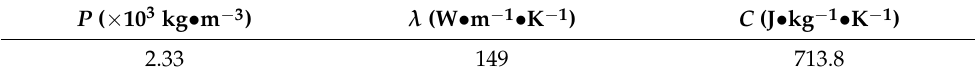
Table 1. Polysilicon properties.